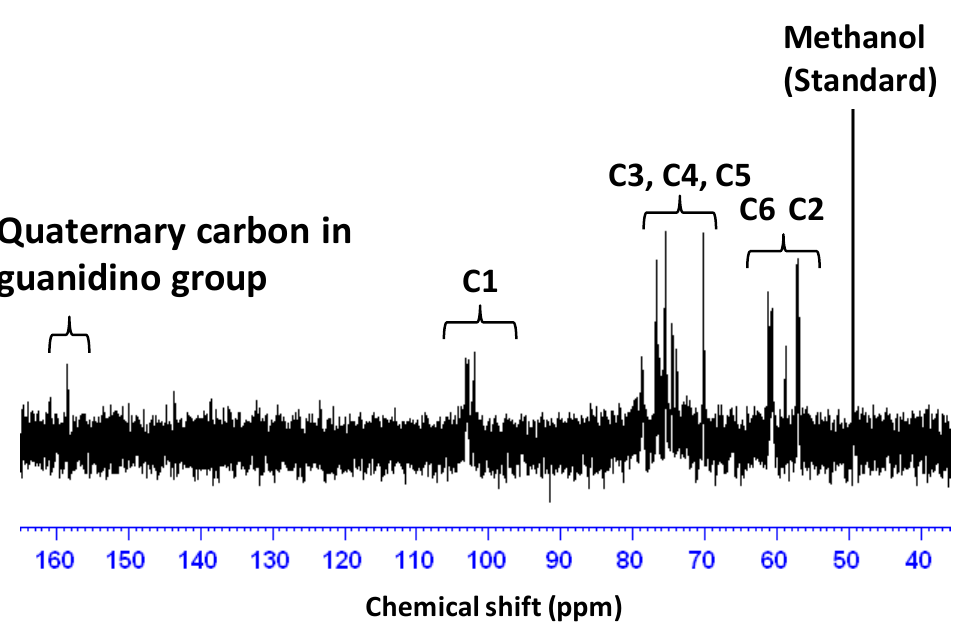
Figure 2. 13 C NMR spectrum of GCOS in D 2 O. This spectrum was measured in the presence of methanol as an internal standard. The signal due to methanol was adjusted to 49.5 ppm [23].